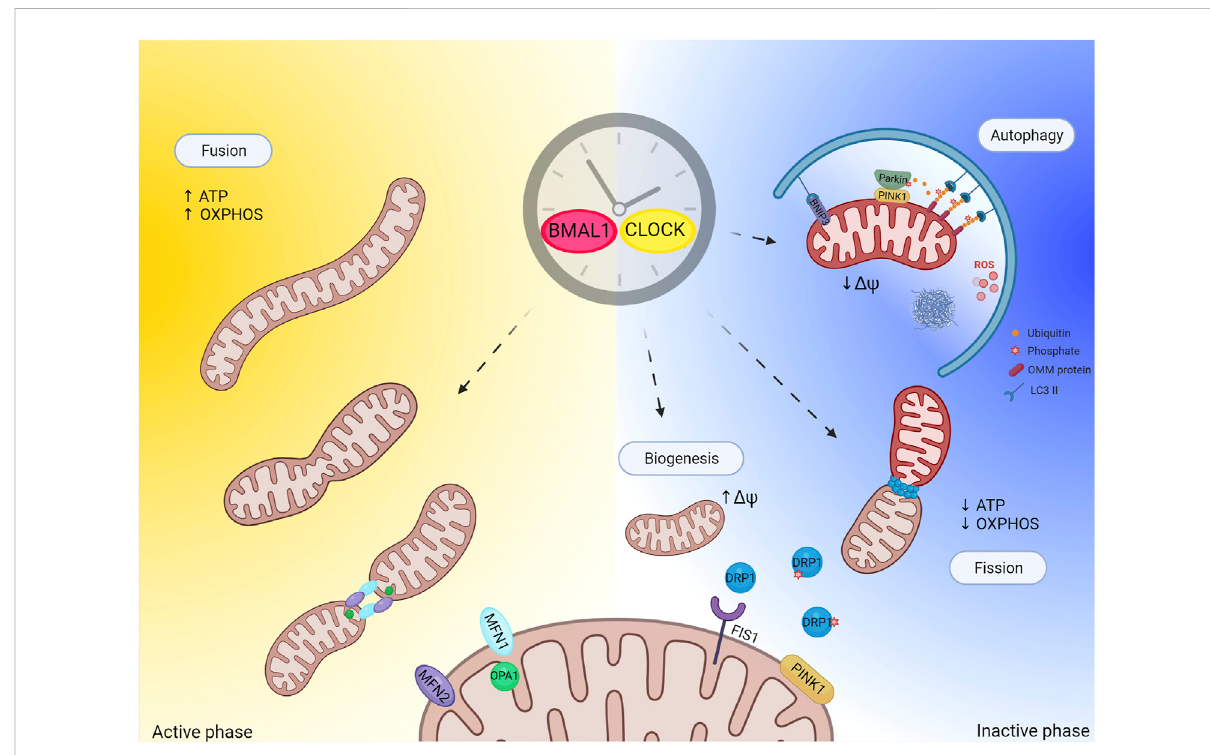
FIGURE 2 Circadian clock and regulation of mitochondrial quality control. Figure depicts hypothetical regulation of mitochondrial quality control by the clock. Mitochondriaquality control (mitophagy and biogenesis inparticular)strongly relayson mitochondrial dynamic (fusion and fi ssionevents). Mitochondrial fi ssion generates uneven daughter units, one unit exhibiting increased mitochondrial membrane potential and high probability to fuse, while the other has decreased mitochondrialmembranepotentialandisdegradedbyautophagy.Thecircadianclockregulatesmitochondrial fi ssiontoallowmitochondrialadaptationto daily metabolic changes. This regulation might also extend to mitochondria quality control. Importantly, one proposed function of sleep (inactive phase) is preventionofoxidativestressbuildupanddegradationoftoxiccompounds.Inlightofthis,onepotentialphysiologicalroleofsleepduringtheinactivephasecould be to promote mitochondrial quality control as antioxidant response. Created with